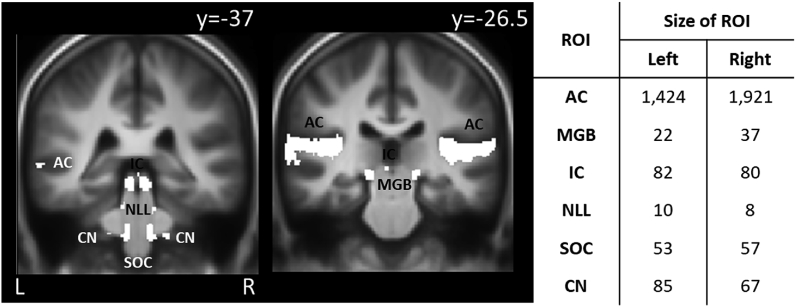
Left: Illustrative coronal slices showing the ascending auditory pathway ROIs as defined from the ‘OR’ combination of binary masks generated from the random effects GLMs of the onset, offset and sustained responses of all (n = 62) participants at p < 0.01 family-wise error (FWE) corrected. ROIs are shown in the cochlear nucleus (CN), superior olivary complex (SOC), nucleus of the lateral lemniscus (NLL), inferior colliculus (IC), medial geniculate body (MGB) and auditory cortex (AC), and overlaid on the group-level mean MPRAGE image (L = left, R = right), ‘y’ denotes the MNI slice co-ordinates. Right: Number of voxels (1.5 mm isotropic) in each ROI by hemisphere.